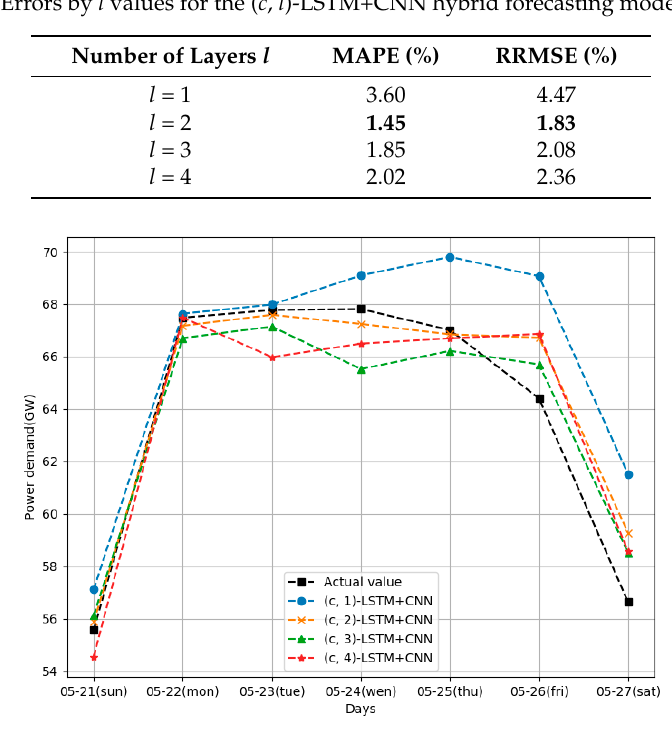
Figure 8. Power demand forecasting results for l values.